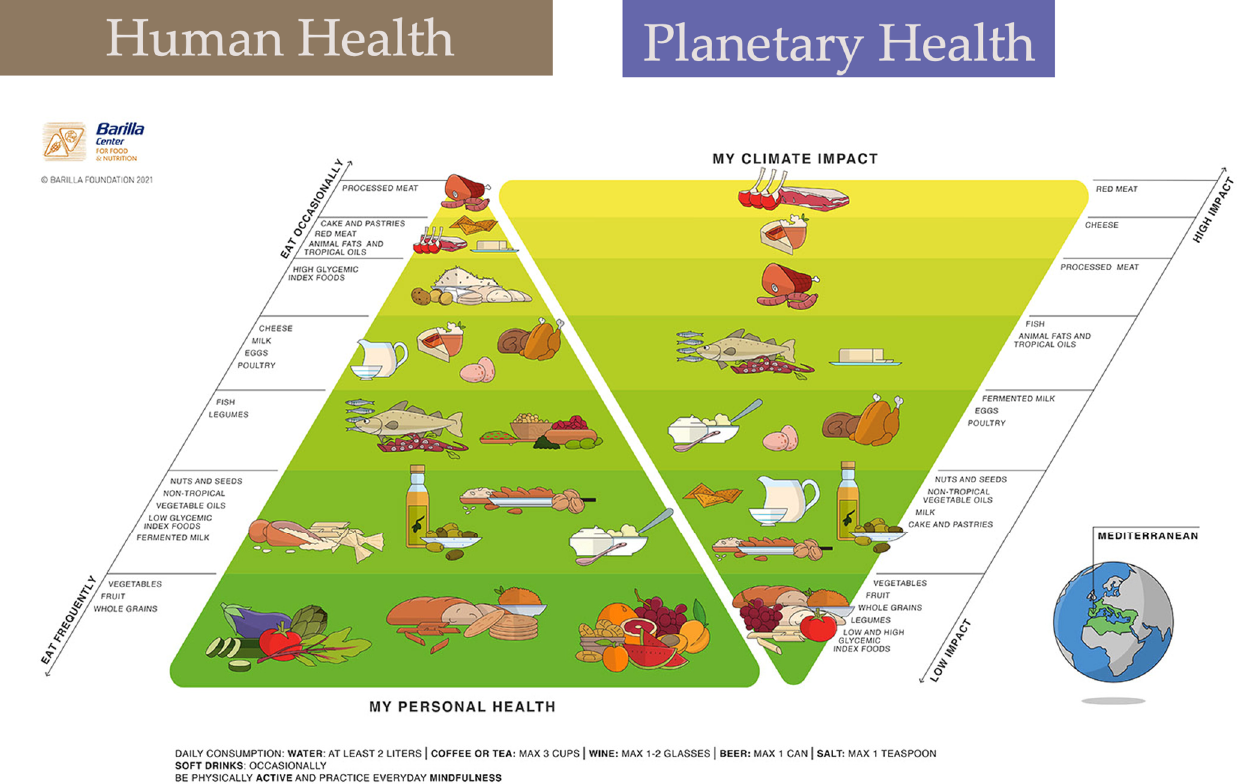
Figure 1. One-health outcomes of the Mediterranean Diet according to the double pyramid model (Source: Barilla Foundation 2021 [7]).